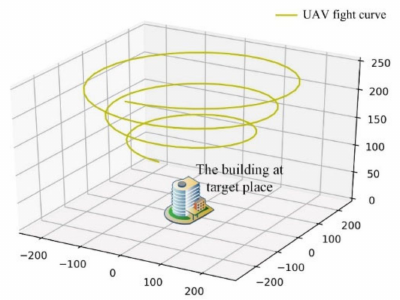
Figure 2. The flight trajectory of synthesized UAV